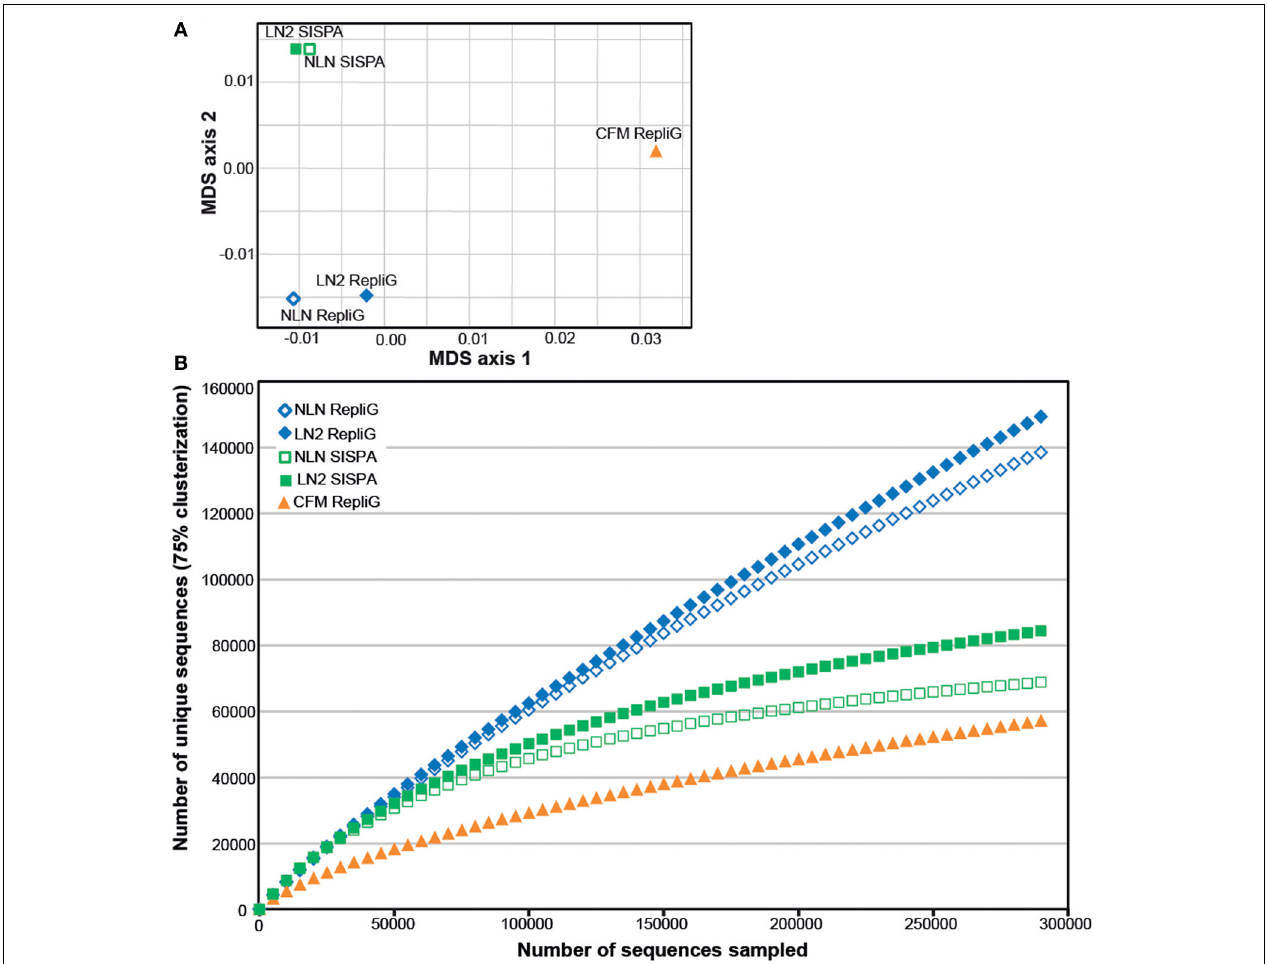
FIGURE 4 | Diversity analysis of the Pocillopora damicornis DNA virome data sets. Each data set was generated from a uniform tissue homogenate using either a chloroform-based method (CFM) or a mechanical bead-beating method (MECH) to disrupt cells. The latter method included either an additional liquid nitrogen storage step (LN2) or samples were processed immediately from fresh tissue (NLN). The